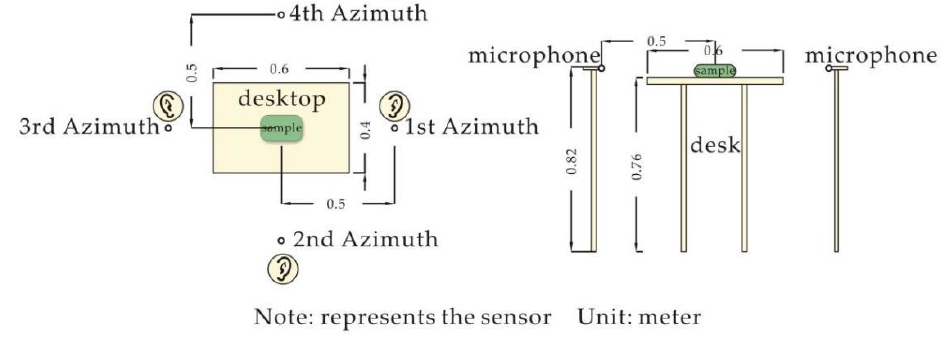
Figure 3. Layout diagram of instrument and equipment.